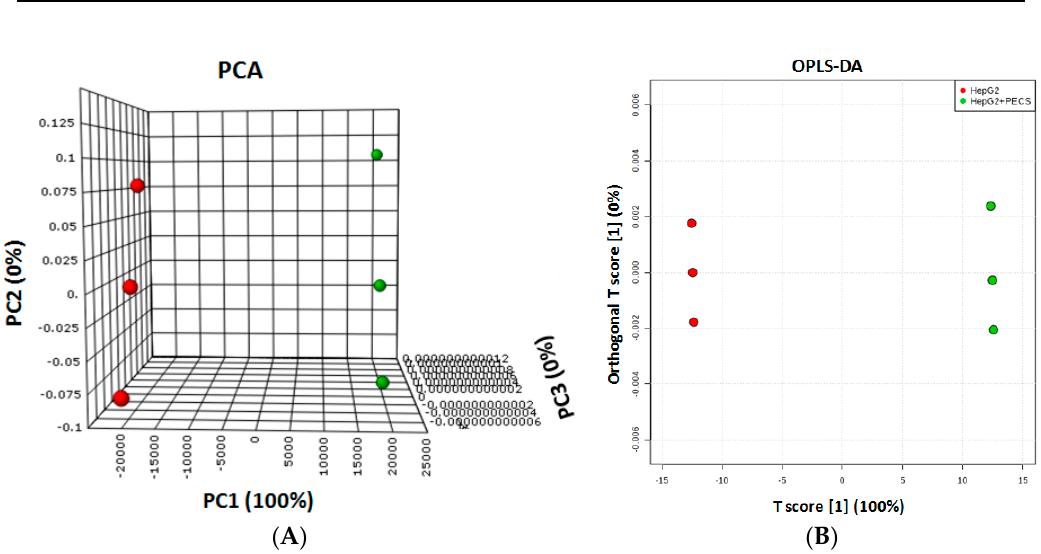
Figure 4. PCA ( A ) and OPLS-DA ( B ) plot obtained for HepG2 cells in triplicate, before (red circles) and after (green circles) PECS treatment.